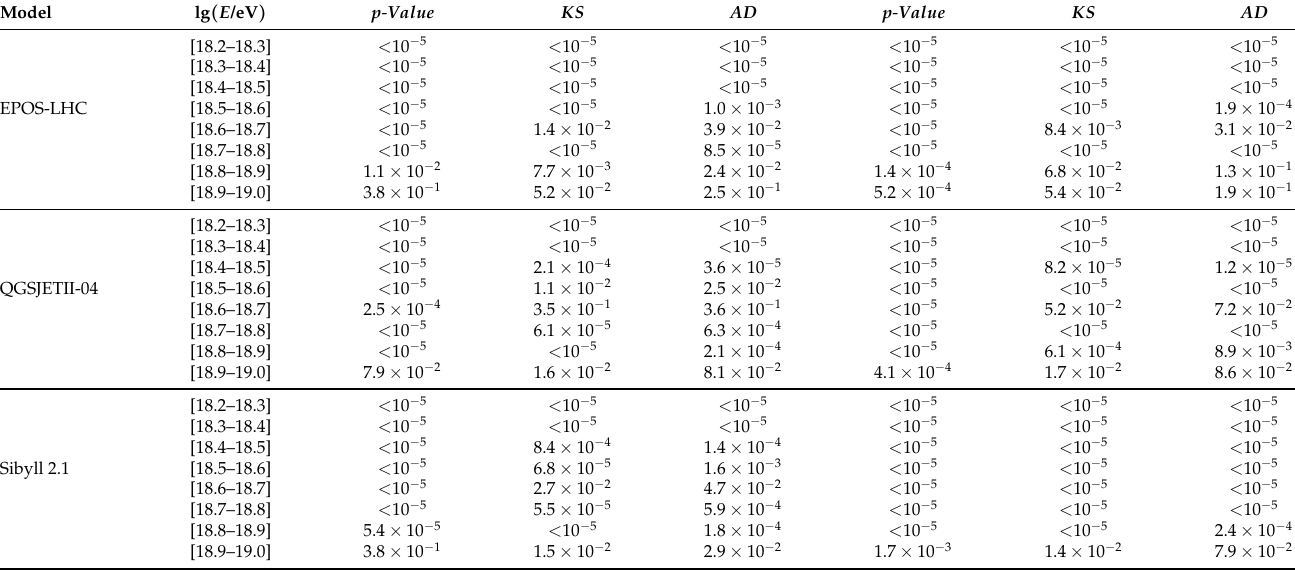
Table 2. The probabilities computed for the three statistical tests of the comparison Auger data vs. X TA the TA fractions obtained using method #1 (left) and #2 (right) .